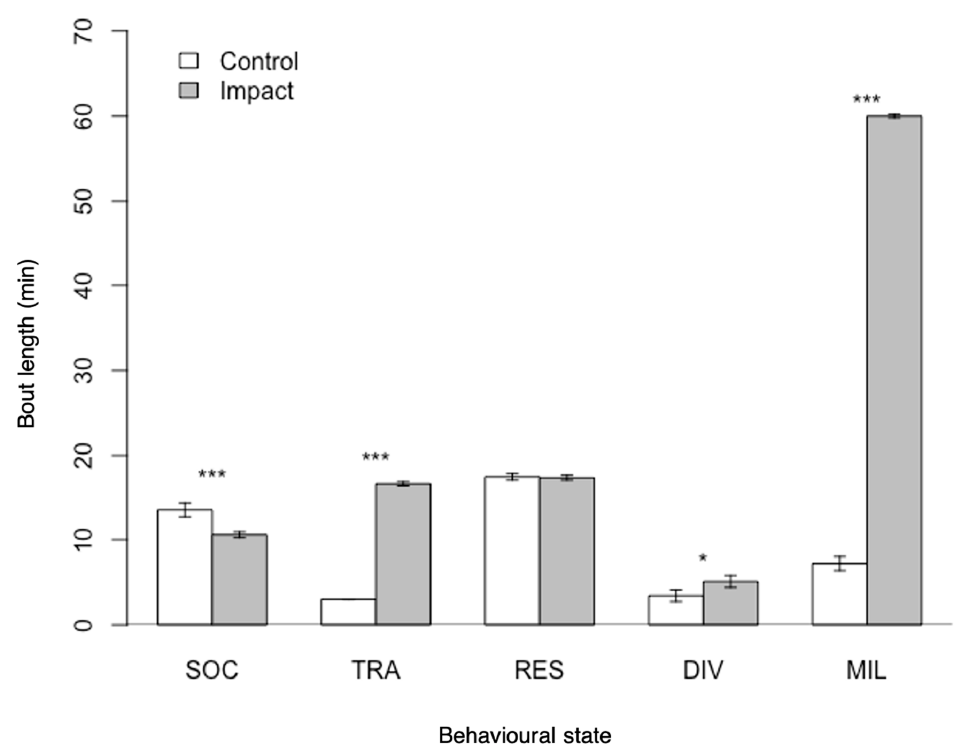
Figure 4. Average bout lengths of the behavioural state of spinner dolphins in the presence (impact) and absence (control) of dolphin-watching vessels. Error bars represent 95% confidence intervals. Significant differences are indicated with an asterisk (* p < 0.05, *** p < 0.001). SOC: socialising; TRA: travelling; RES: resting; DIV: diving; MIL: milling.